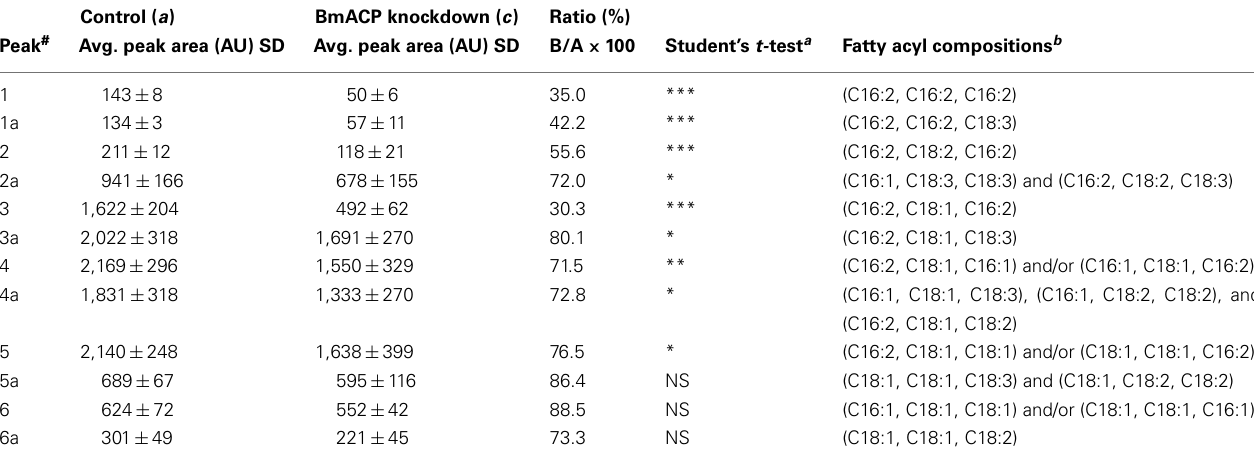
Table 2 | Comparison of peak areas in Figures